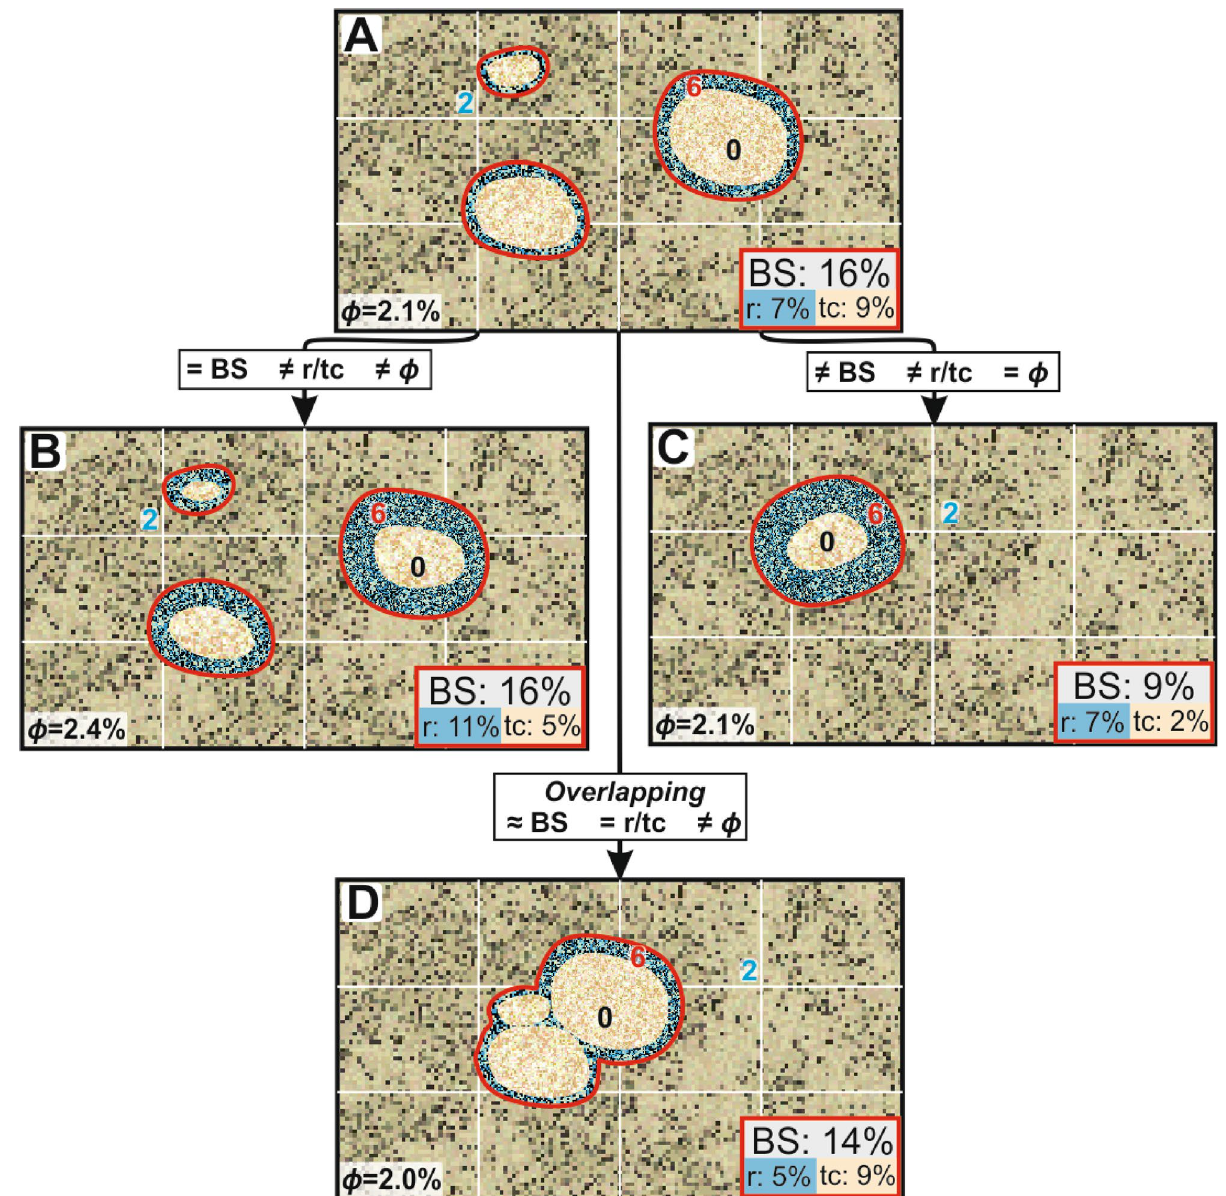
Figure 3. Theoretically modeled porosity effect by Macaronichnus . ( A ) Model scenario to be compared with 16% of bioturbated surface (BS) and porosity ( ) 2.1%. ( B ) Situation with same BS, but different rim/tube core ratio (r/tc), causing an increase in . ( C ) Scenario with same (2.1%) in spite of the lower BS, due to a higher r/ ϕ tc. ( D ) Overlapped burrows with a very similar BS, but a decrease in rim surface due to crosscutting, reducing ϕ ϕ Bold numbers represent porosity from host sediment (blue), rim (red), and tube core